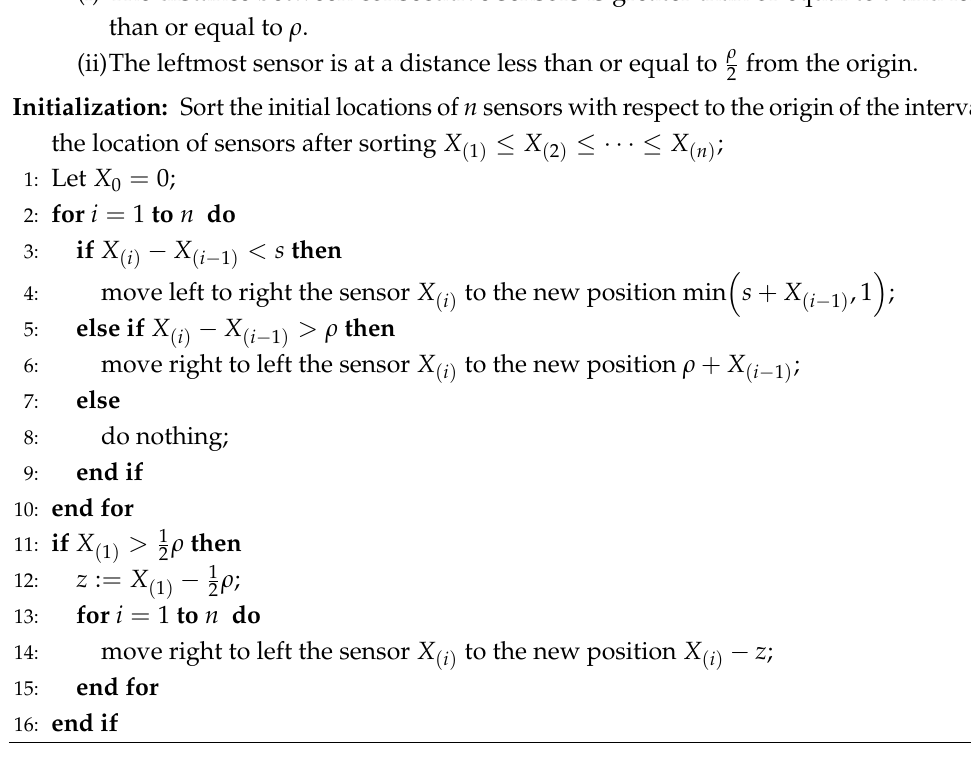
Algorithm 1 MV ( n , ρ , s ) moving sensors on [ 0, 1